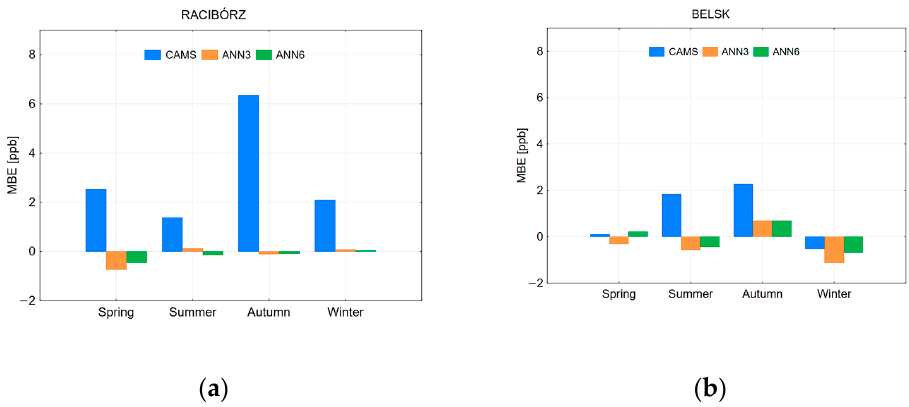
Figure 13. MBE for the best CAMS forecast, ANN3 and ANN6 for Racibórz ( a ) and Belsk ( b ).